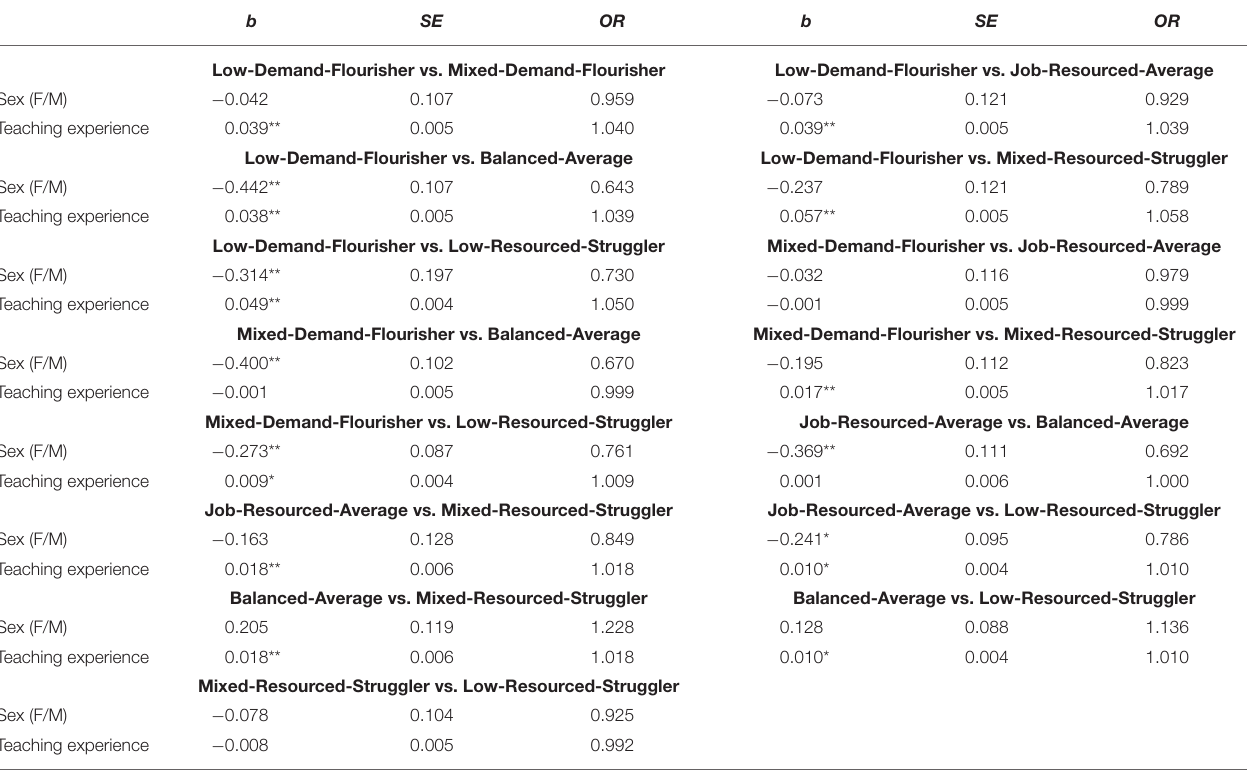
TABLE 4 | The role of teacher characteristics in predicting profile membership in both countries (Single-level LPA). b SE